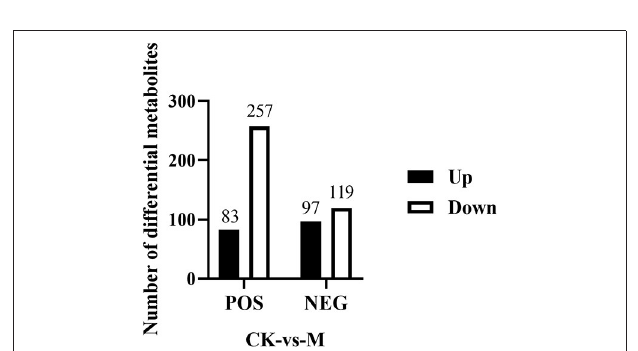
FIGURE 4 | Number of differential metabolites identified in the splenic B cells post EgPSC infection. Those metabolites with a P -value of T -test < 0.05 and |FC| ≥ 1.5 were considered differential metabolites between control and model groups. n = 5–6 mice per group. CK, control check; M, model